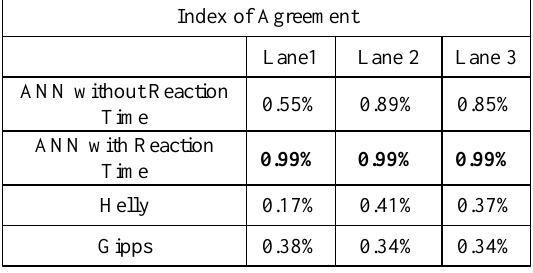
Table 2. Statistical summary for each observed and simulated vehicle ( d is index of agreement)